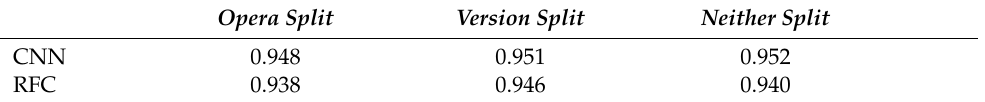
Table 1. F-measures on the test set for both systems, using the full variants of the split, respectively. Opera Split Version Split Neither Split CNN 0.948 0.951 0.952 RFC 0.938 0.946